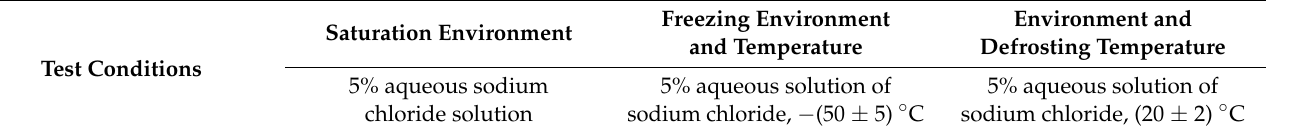
Table 6. Test conditions for concrete specimens.